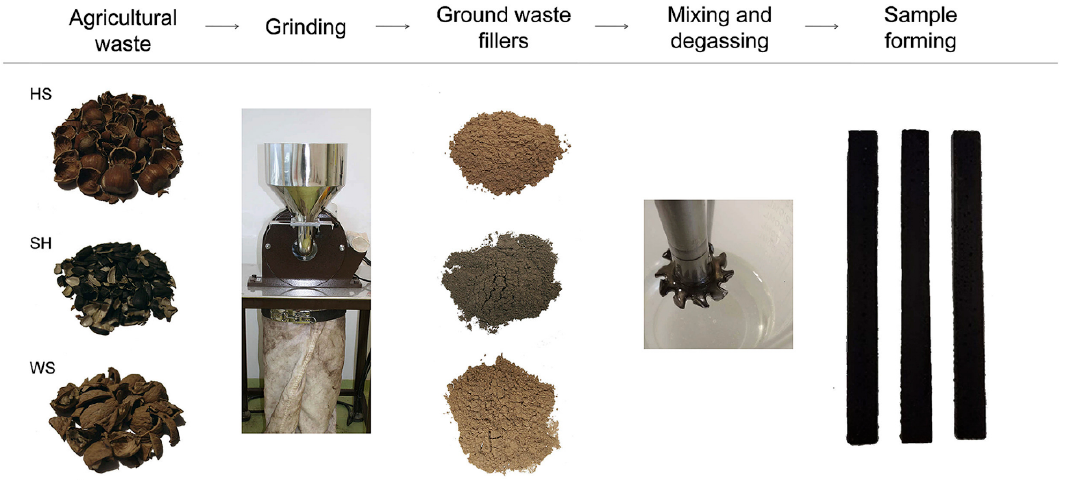
Figure 4. Fabrication steps of sunflower husk, hazelnut shell, and walnut shell-based epoxy compo-